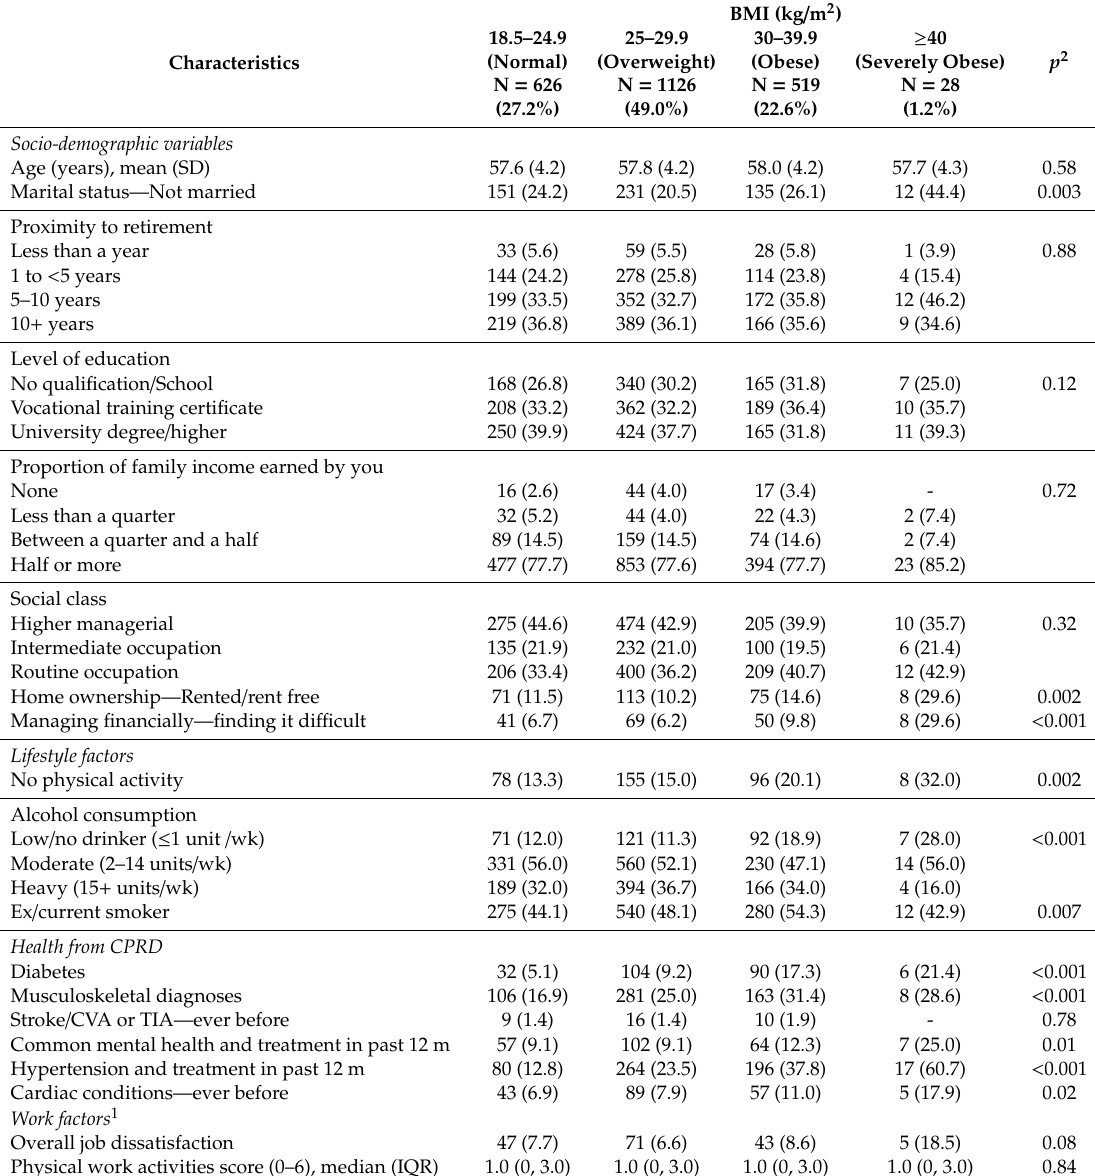
Table 1. Baseline characteristics of men, by categories of body mass index